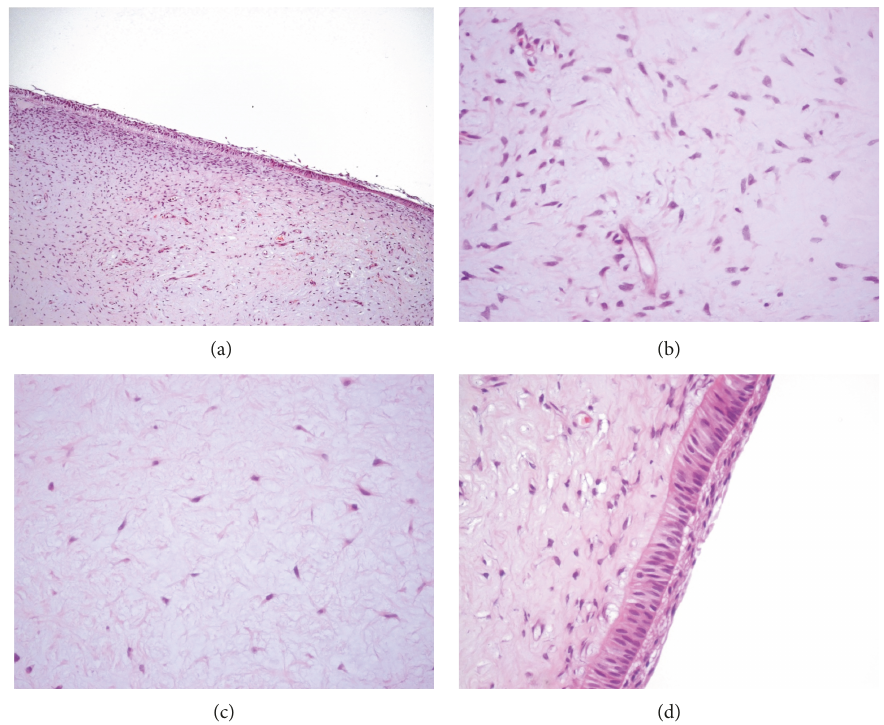
Figure 2: Microscopically, the lesion was characterized by a loose connective tissue recovered by a columnar epithelium (a). Areas with di ff erent cell densities were noticed in the specimen (b, c). In some regions, upon the columnar cells, 3 layers of strati fi ed squamous cells were detected exhibiting an outer enamel epithelium-like morphology (d). Scale bar: (a): 80 μ m; (b – d): 20 μ